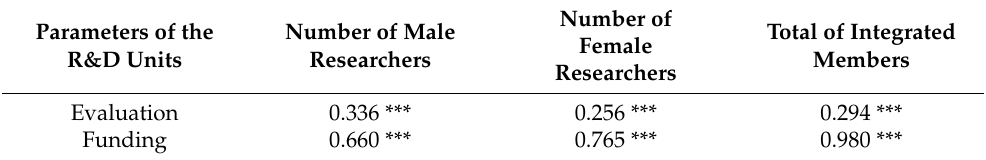
Table 7. Correlations between evaluation and funding with the number of researchers in the team (Pearson’s r